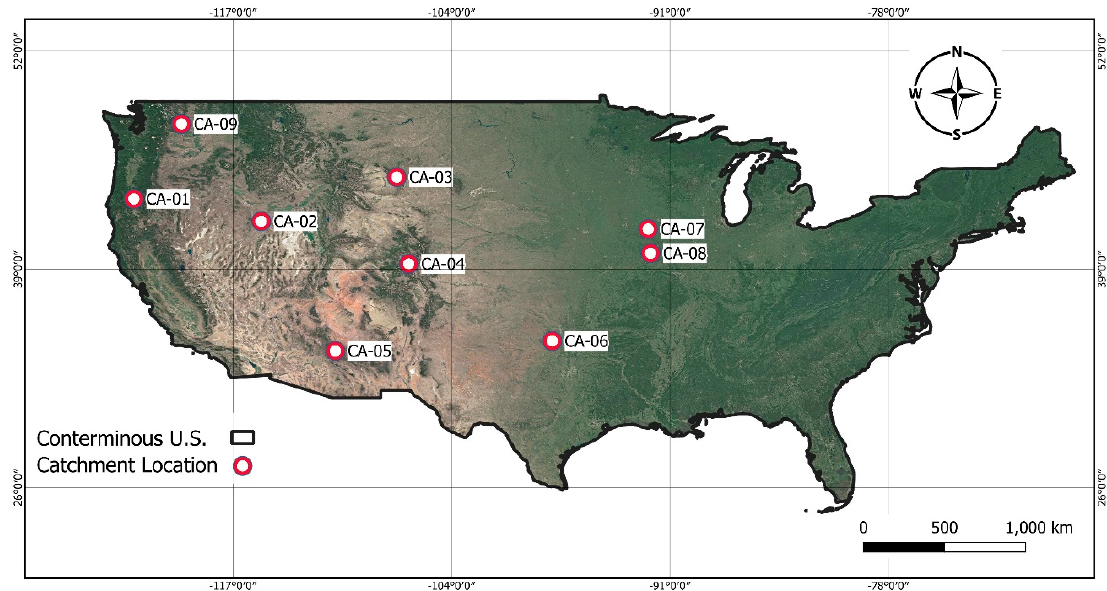
Figure 9. The selected nine catchments’ locations on a satellite-based image.